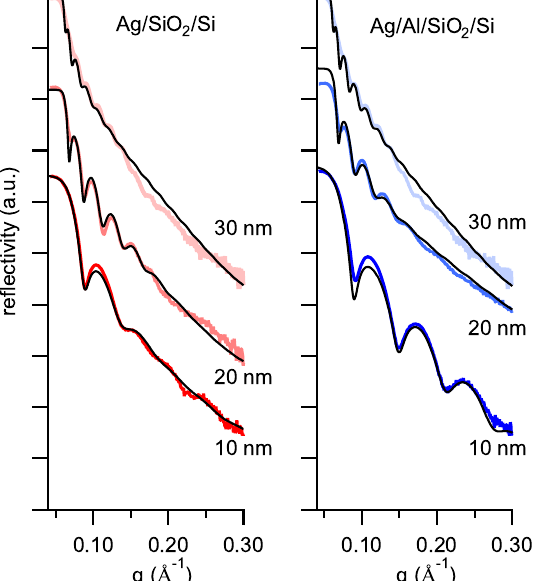
Figure 6. XRR patterns for silver film deposited on Si without ( left ) and with ( right ) Al seed layer. The silver films were deposited for 30 s, 60 s, and 90 s, and the aluminum layer for 15 s. This results in Ag films of approximately 10, 20, and 30 nm and a Al film of 0.5 nm. The color traces show the experiments, while the black lines are simulated patterns using Motofit